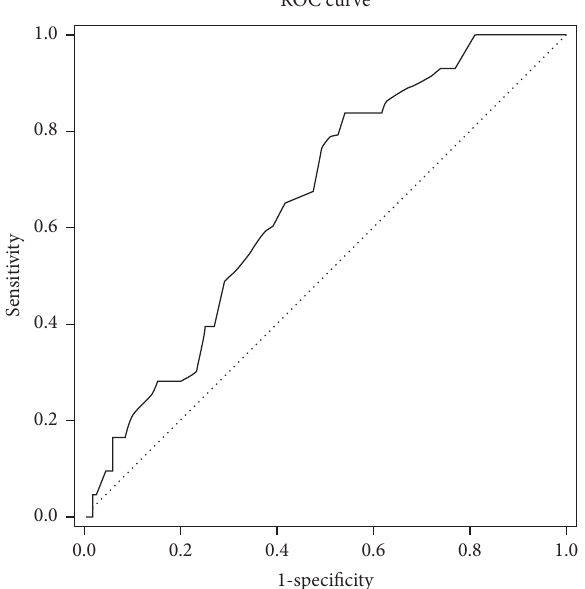
Figure 5: ROC analysis chart for age according to ODI success. For age 44 cutting value, sensitivity was 83.72%, specificity 45.83%, the positive predictive value is 35.64, and the negative predictive value is